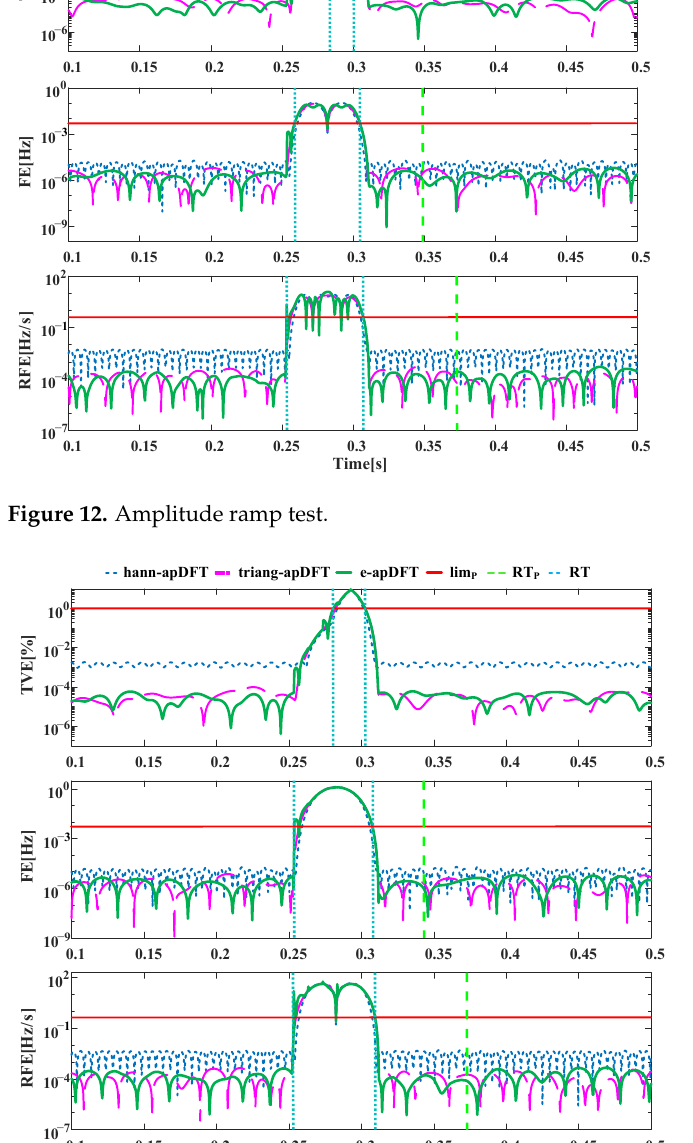
Figure 13. Phase step